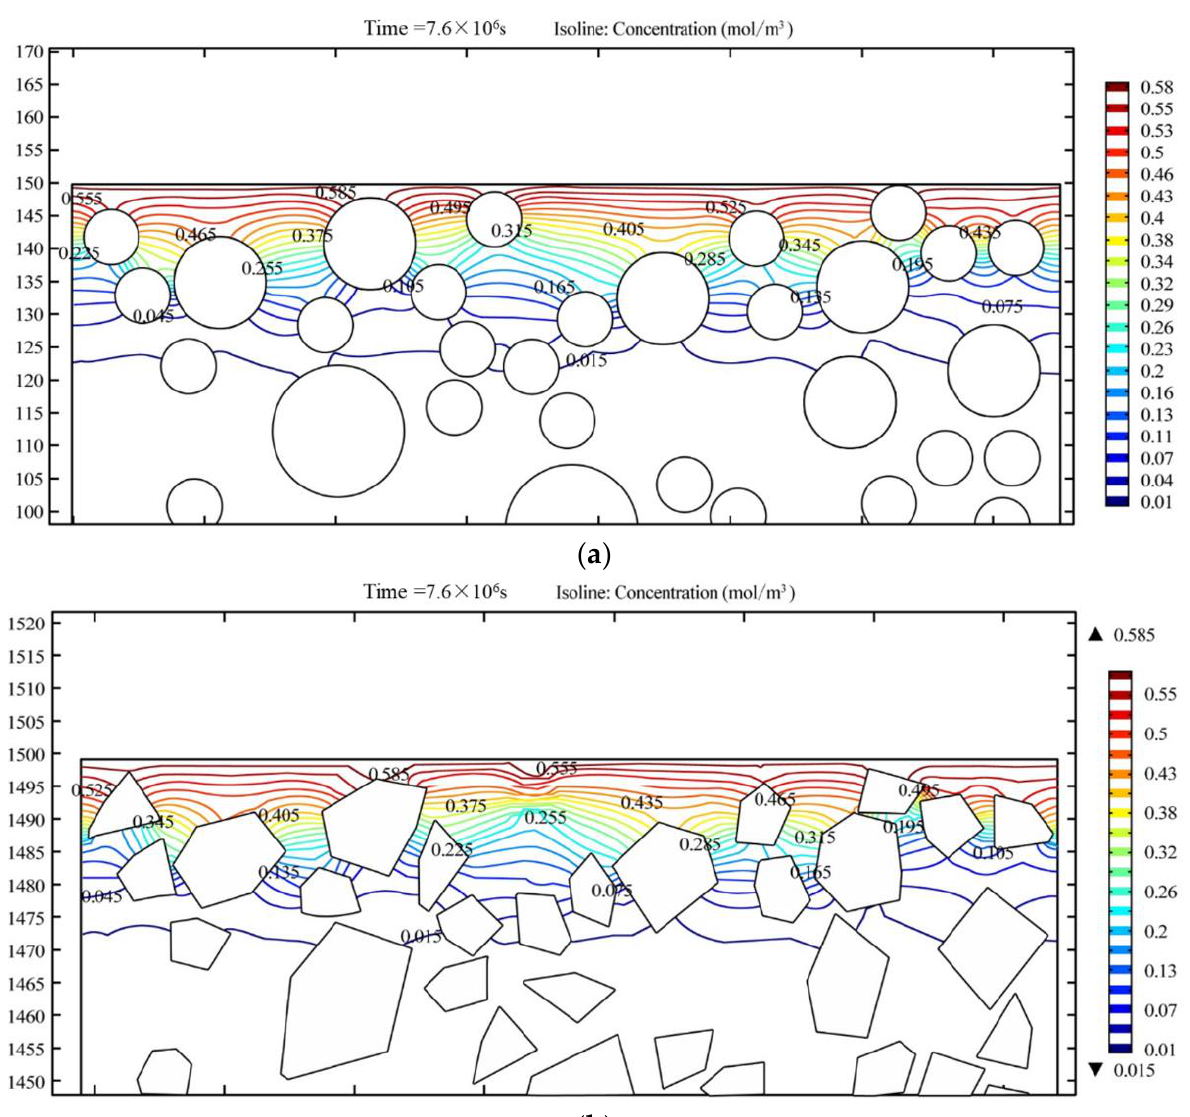
Figure 14. Numerical simulation results of specimens HPC 50 with circle and square aggregate: ( a ) Circle aggregate; ( b ) Square aggregate.